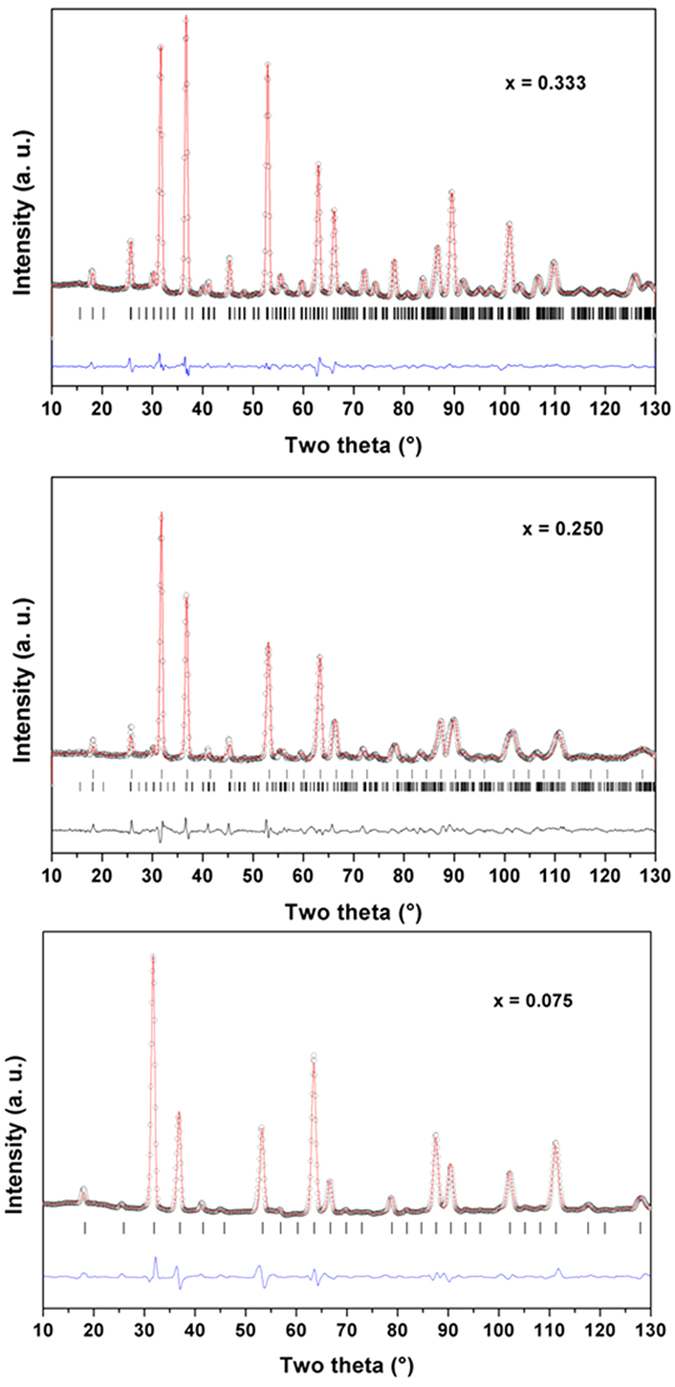
Rietveld refinement plots for powder ND data of representative compositions in SrTi1−2xFexTaxO3 system.(x = 0.075, 0.25 and 0.33).